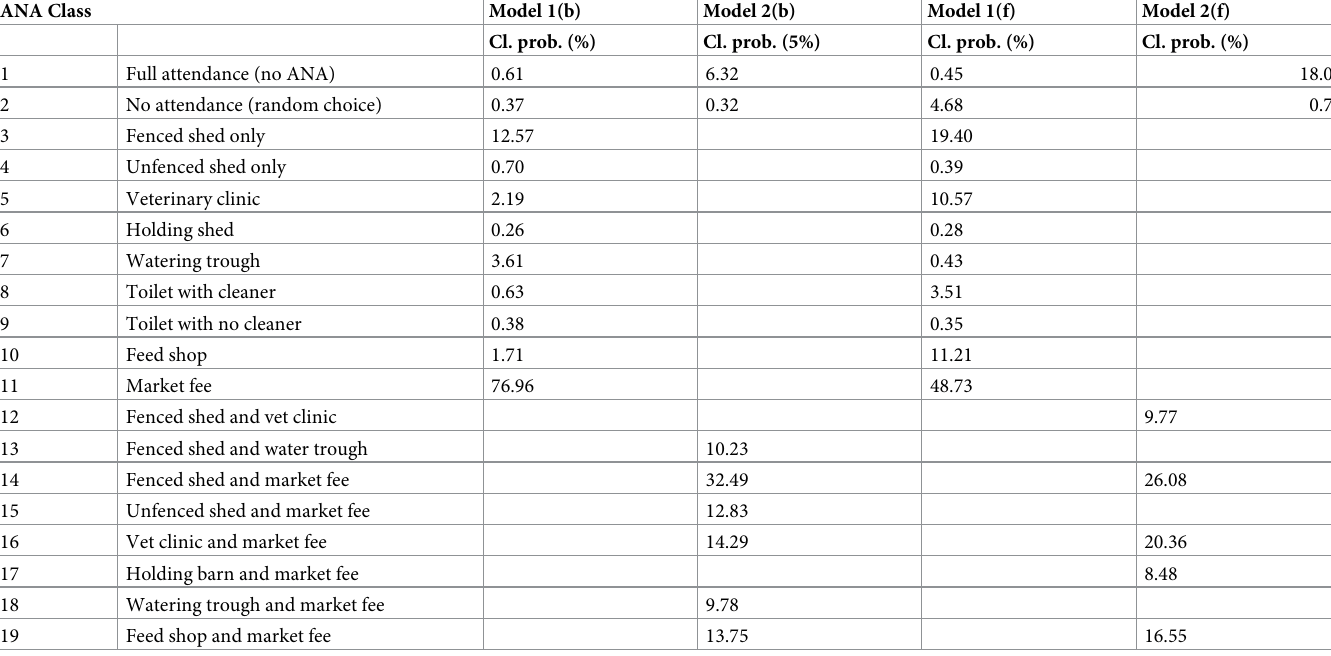
Table 6. Probabilities of ANA classes before and after the nudge–LCM